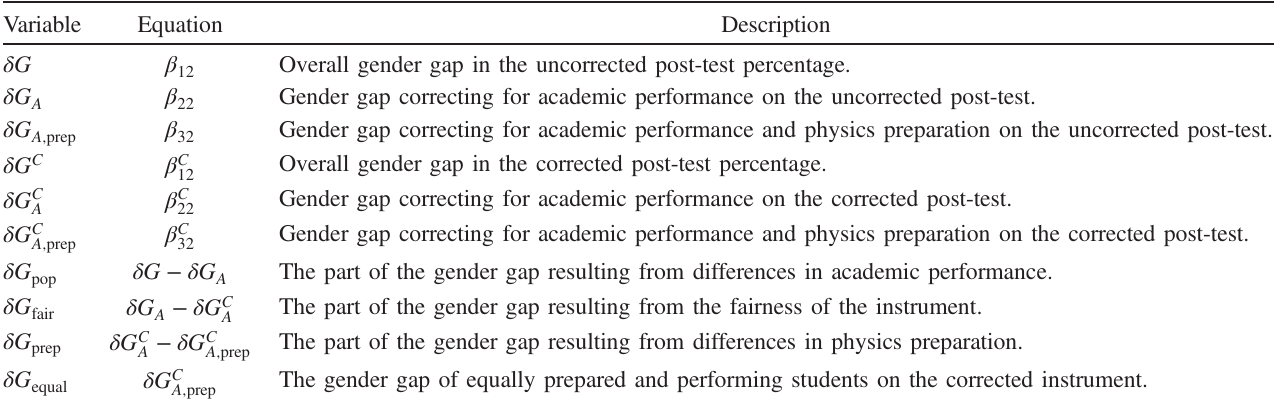
TABLE IV. Summary of variables used in partitioning the gender gap.